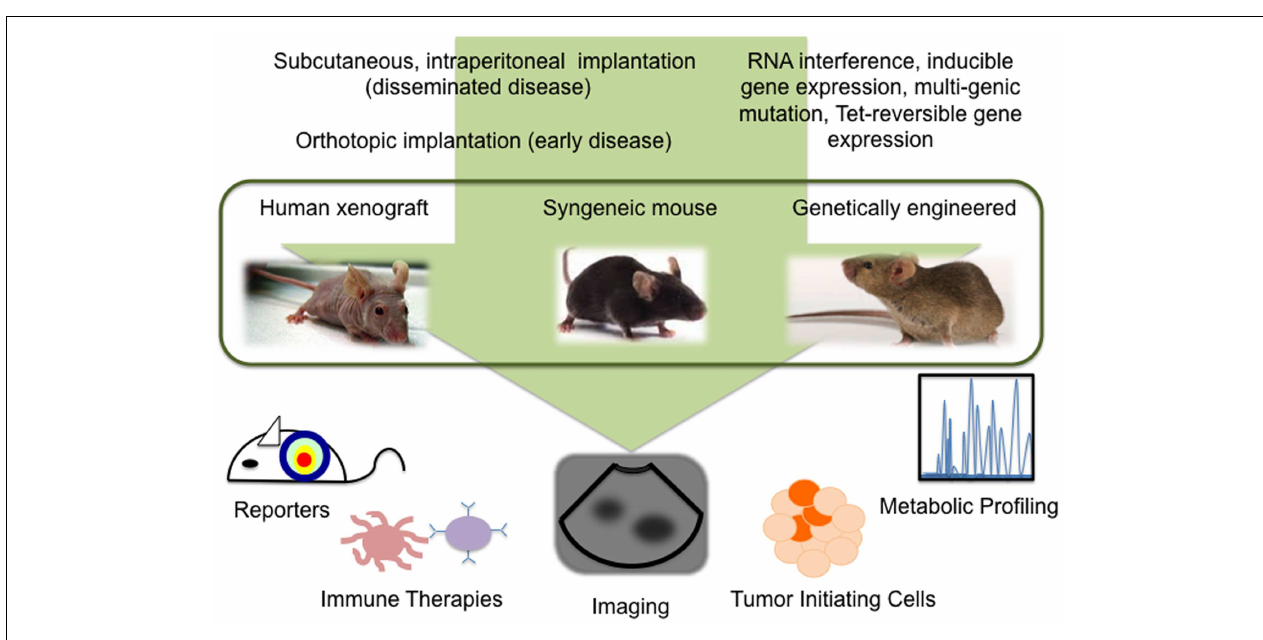
FIGURE 1 |Technological advances in mouse models allow detailed study of ovarian cancer biology